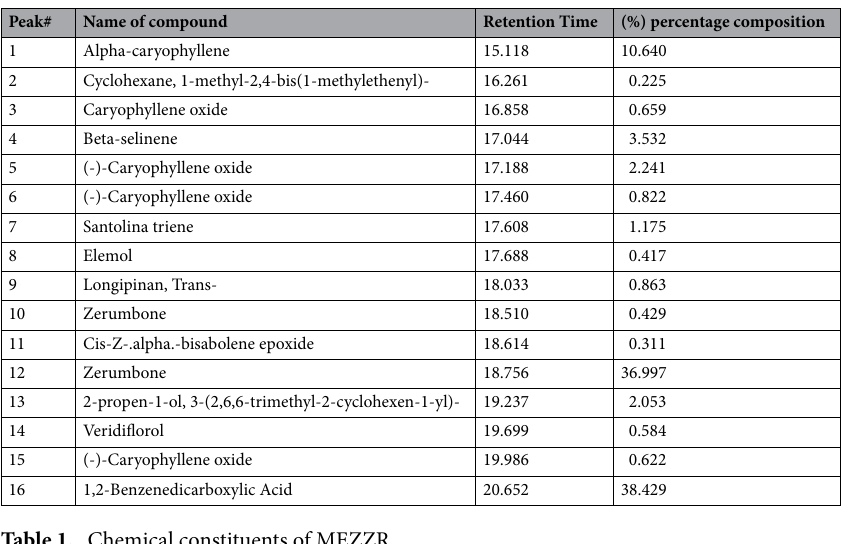
TFC (mg of catechin equivalent/g of